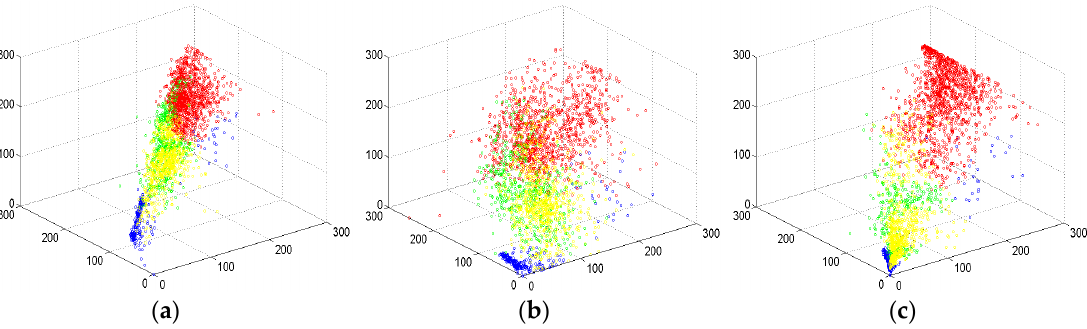
Figure 8. Scattering plots of the decomposition results by ( a ) the MCSM method, ( b ) the Y4R method, and ( c ) the improved MCSM decomposition method (red: urban areas; green: vegetated areas; blue: water areas; yellow: bare soil areas.)